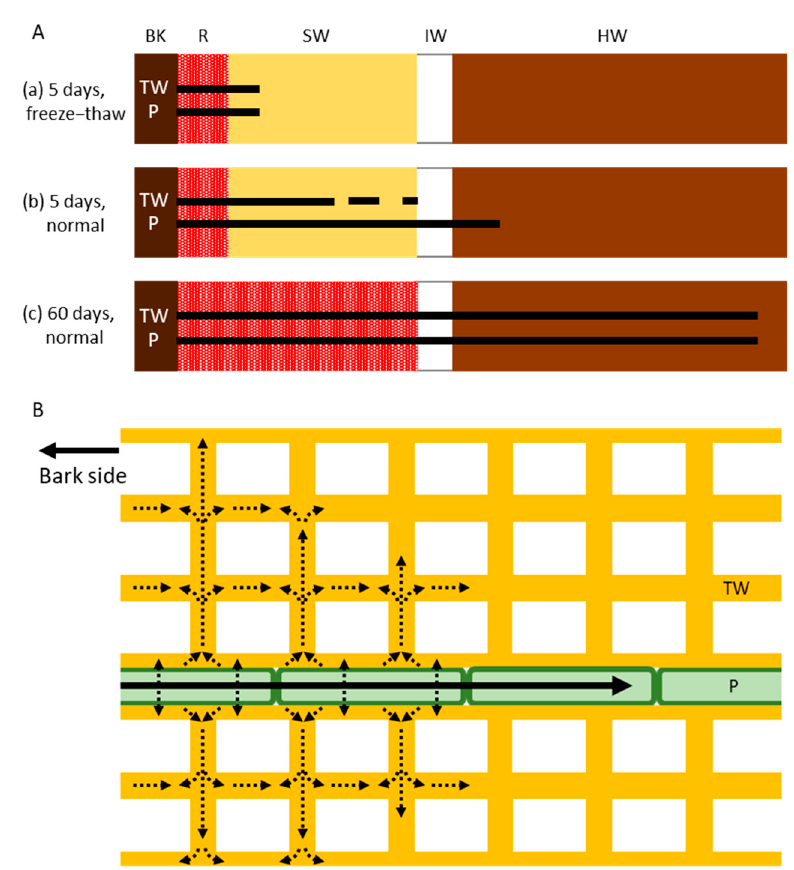
Figure 6. Schematic drawing of the radial movement of cesium (Cs) in the trunk of Japanese cedar ( Cryptomeria japonica ) trees. ( A ) Distribution of Cs in the xylem after ( a ) 5 days of injection in freeze–thaw-treated trees (showing movement by di ff usion alone without living cells); ( b ) 5 days of injection in normal trees (showing movement by both active transport and diffusion); and ( c ) 60 days of injection in normal trees (showing movement by both active transport and diffusion). Bars and dots represent the distribution of Cs. ( B ) Subcellular movement of Cs in tracheids and ray parenchyma cells. Cs is transported symplasmically by the ray parenchyma cells (black arrow) and is then exuded and di ff used into the tracheid cell walls (dotted arrows). BK, bark; R, red area stained by acid fuchsin; SW, sapwood; IW, intermediate wood; HW, heartwood; TW, tracheid cell wall; P, ray parenchyma cell.